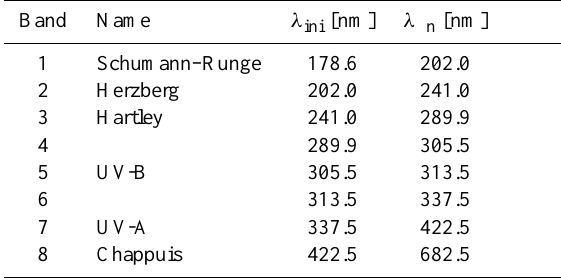
Table 1. Subdivision of the spectral range into eight bands. λ ini and λ fin are the initial and final